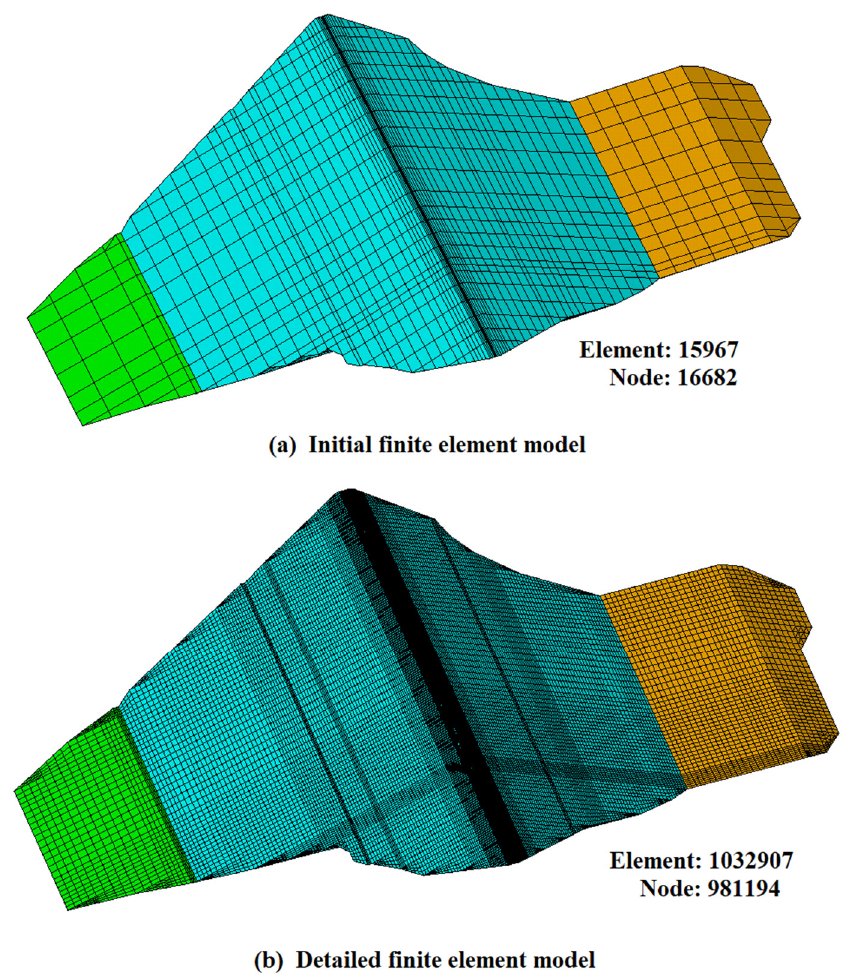
Figure 8. Finite element model of the Pubugou dam.